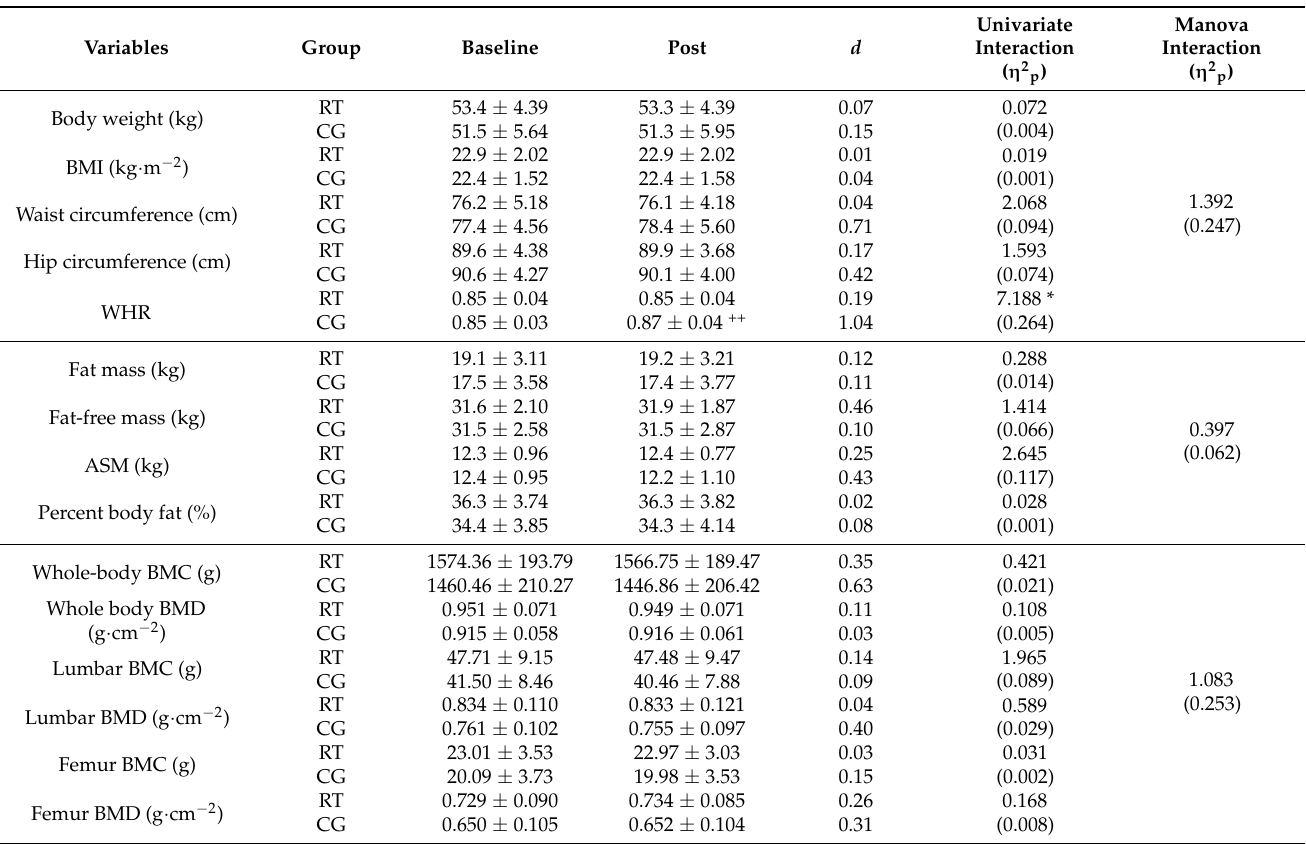
Table 4. Change in participant characteristics, body composition, and bone mineral density during the intervention (M ± SD).